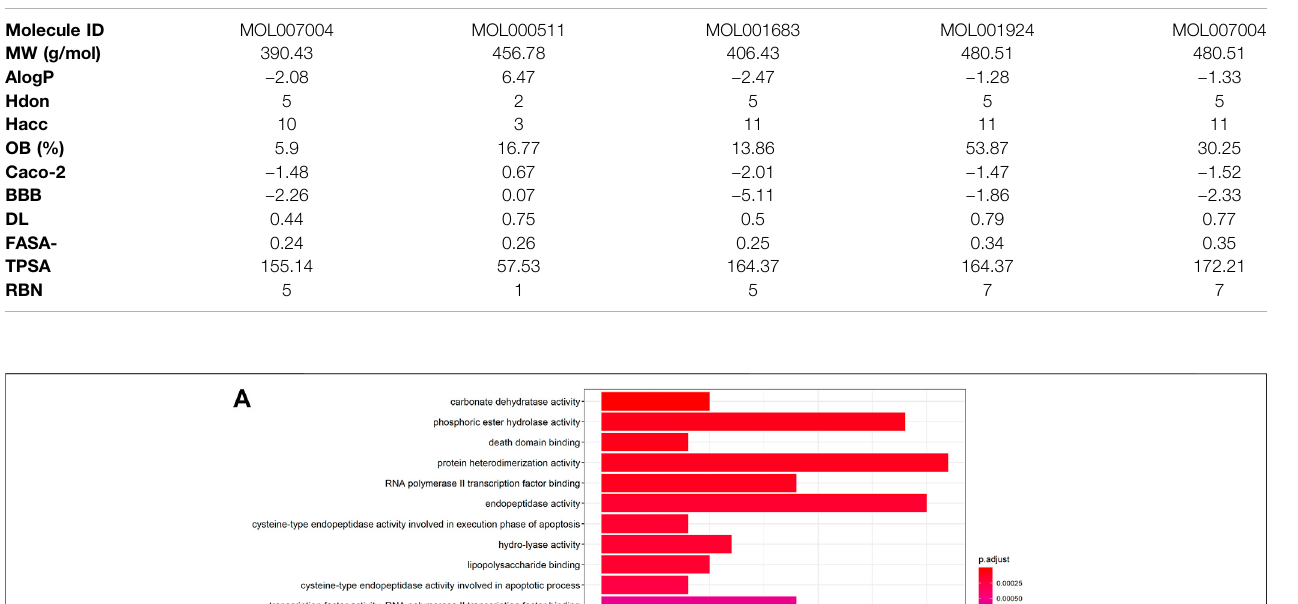
TABLE 1 | Pharmacological and molecular properties of active compounds investigated in this study.